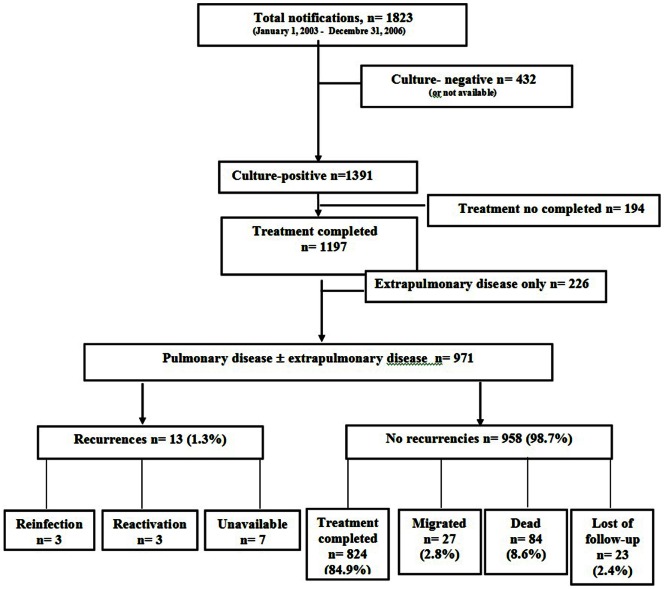
The flow chart of tuberculosis patient selection and evolution.
Barcelona 2003–2009.